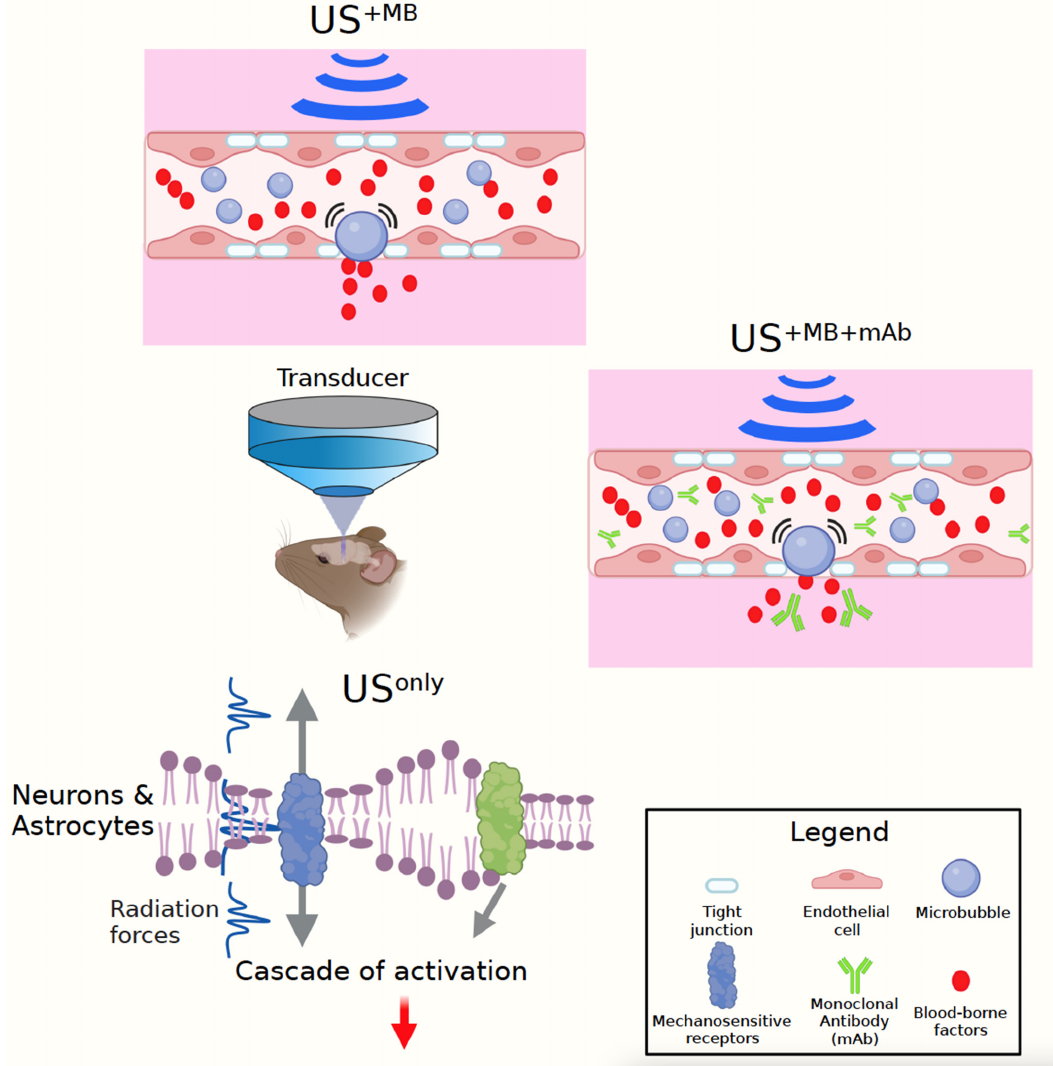
Figure 1. Ultrasound modalities: This review discusses three ultrasound (US) modalities, with a transducer generating the sound waves which travel through the skull into the mouse brain. To open the blood–brain barrier (BBB), microbubbles (MBs) are intravenously injected (US +MB ). Upon US exposure, the MBs start to oscillate (or cavitate) in the brain capillaries, thereby causing pressure on the BBB’s tight junctions that transiently open and make the interstitial space of the brain accessible (US +MB ). This modality relies on the therapeutic effects of endogenous, unidentified blood-borne factors that are taken up by the brain. US +MB+mAb uses therapeutic agents as exemplified by monoclonal antibodies (mAbs) that together with blood-borne factors are taken up by the brain when the BBB opens within the focal volume of the US beam. Finally, US can also be used on its own, in the absence of BBB opening (US only ). The principal mechanisms of US are the generation of heat (for the work discussed here largely negligible), its radiation force, and cavitation, with the latter coming into play, in particular, with the use of MBs in the two modalities US +MB and US +MB+mAb . In US only , in the absence of significant cavitation and heating, the dominating principle is the radiation force (together with the rapid expansion/contraction of neuronal membranes). This is shared between the three US modalities and induces a cascade of activation events in cell types such as astrocytes and neurons, as discussed here. Figure generated with